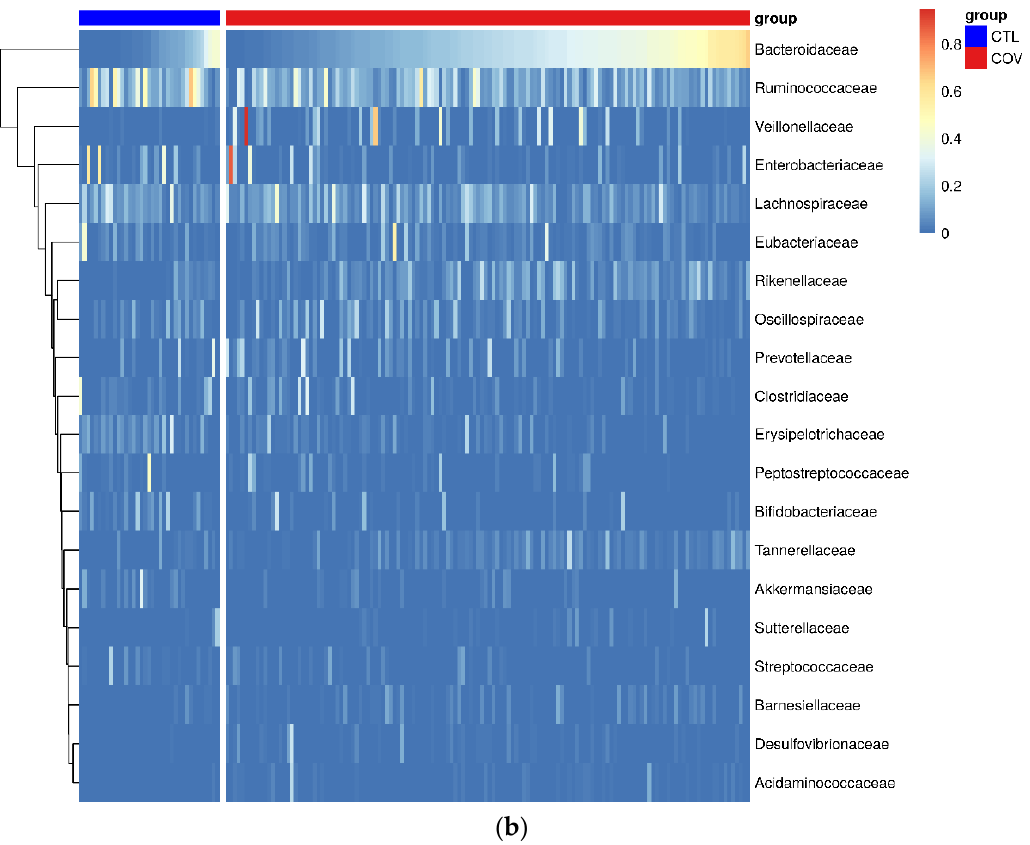
Figure 2. Compositional differences in intestinal microbiota in stool samples from post-COVID-19 patients ( n = 149) and control subjects ( n = 71). ( a ) Top eight phyla and ( b ) top 20 microbial families.